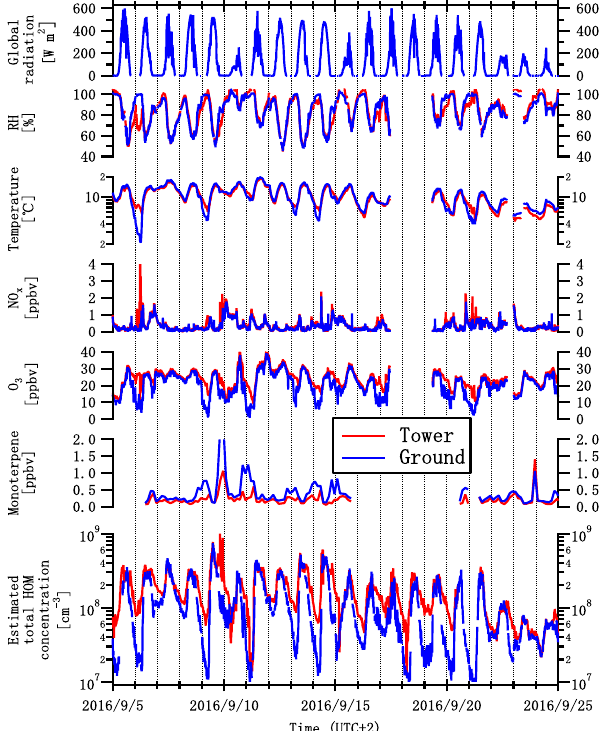
Figure 2. The overall time series of the measured trace gases, mete- orological parameters, and estimated total HOM concentrations at the ground (blue) and tower (red) levels.